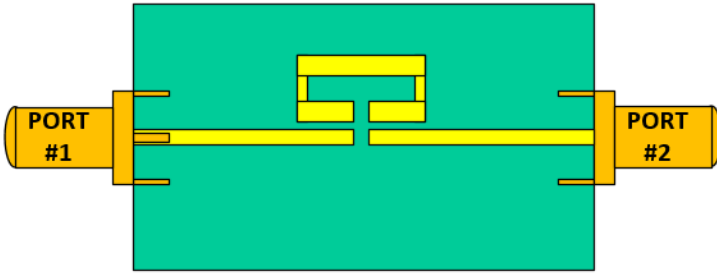
Figure 25. Metamaterial-based conventional sensor.